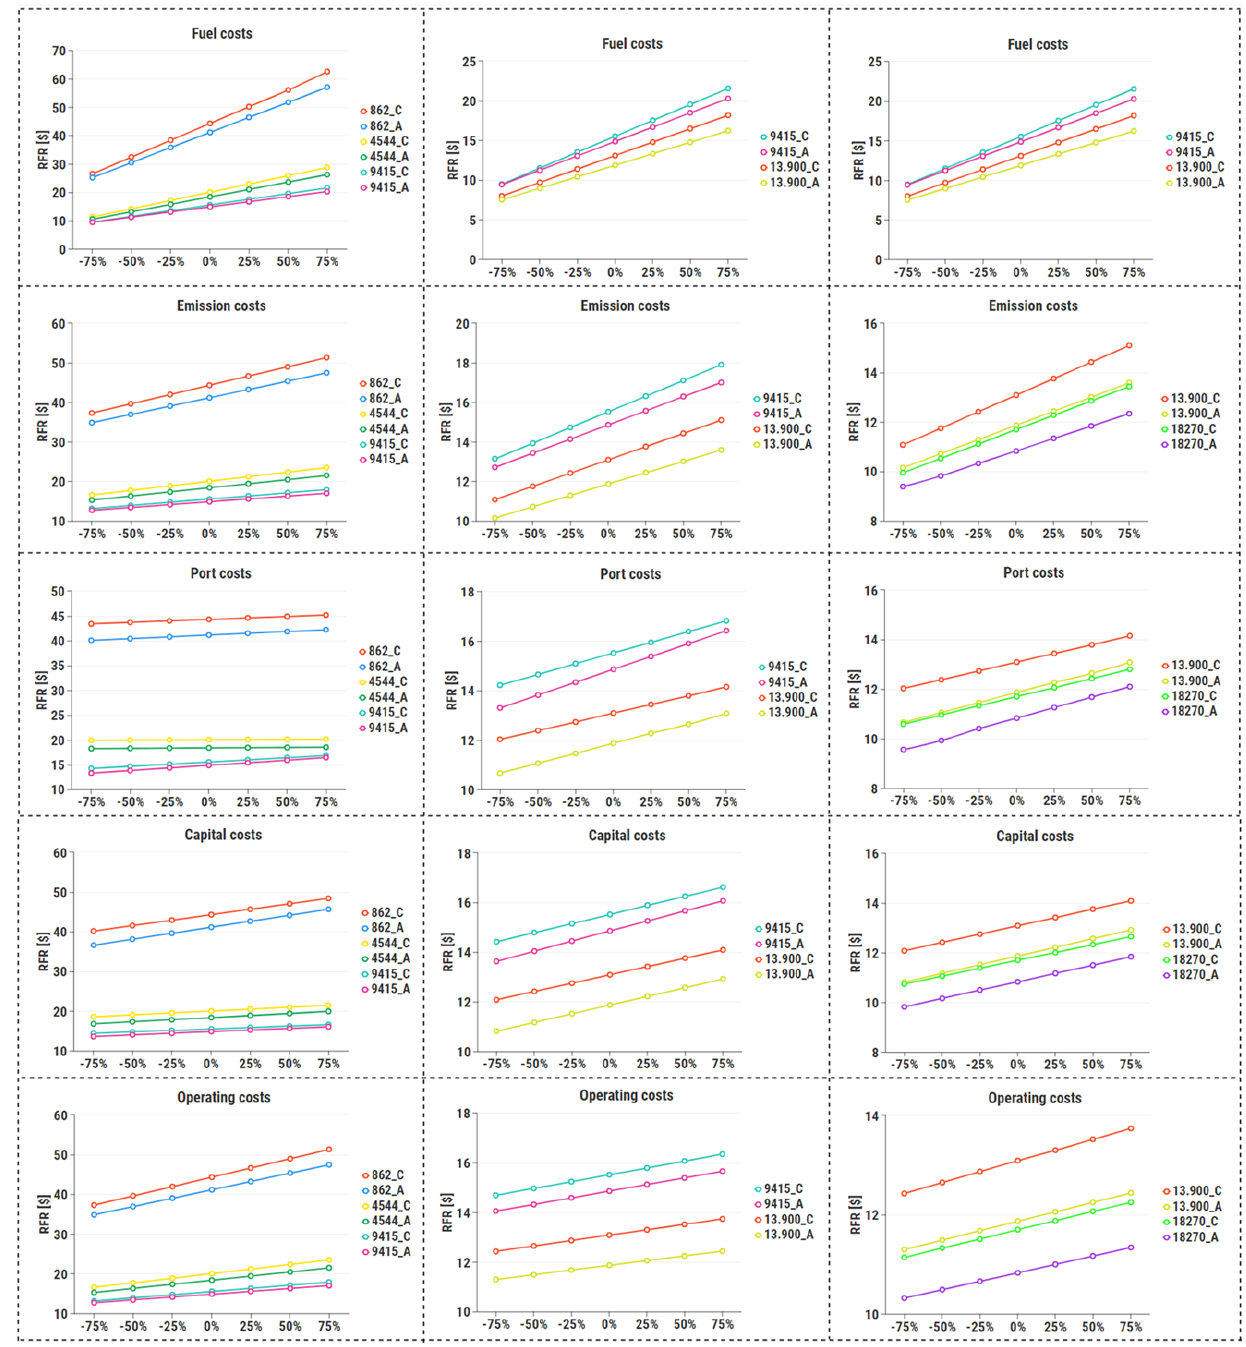
Figure 11. Sensitivity analysis of RFR , for the year 2040, for the conventional and autonomous ves- sel.